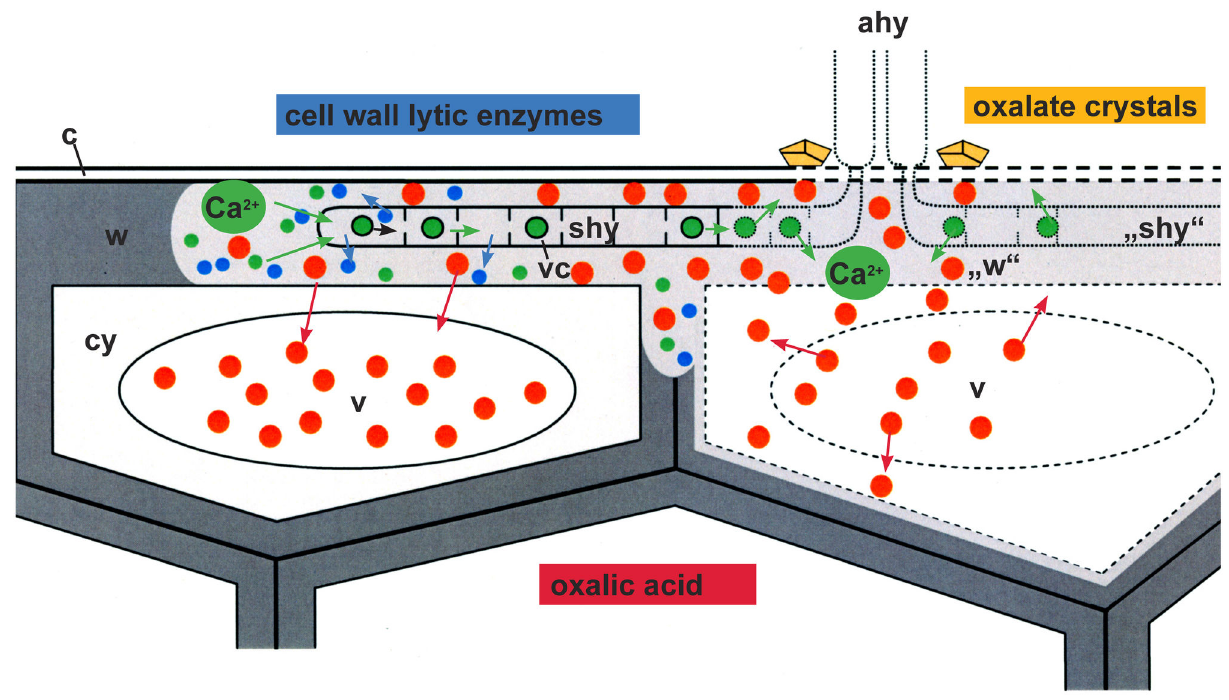
Figure 12. Infection model illustrating the complex interaction between S. sclerotiorum and its host cells sunflower. Scheme of two epidermal cells infected by hyphae of S. sclerotiorum . After penetration of the cuticle (c) by appressorial hyphae (ahy), subcuticular hyphae (shy) grow in the outer epidermal wall layer (w) and live on the cell wall matrix (intact wall in dark grey, degraded cell wall matrix in light grey (“w”). Subcuticular hyphae (shy) secrete cell wall lytic enzymes (blue dots) and oxalic acid (red dots) that do not kill the host cells immediately (intact cell compartments in continuous lines; degraded cell compartments in broken lines). While the enzymes degrade the matrix of the host cell walls and set free calcium (green dots), oxalic acid (red dots) is metabolized by the host cells and stored in the host cell vacuoles (v). Calcium is taken up by the growing hyphae in vesicles (vc) and translocated back to the older part (“shy”) to prevent un-physiological high calcium concentrations. Finally, host cells die (broken lines), because the degradation of cell walls advances and the concentration of oxalic acid rise. Oxalic acid (red dots) and also vacuolar enzymes of the host cells are set free and an autolytic degradation start from the inner side of the host cell walls contributing to the development of necrotic tissue. After death of the senescent hyphae (broken lines), calcium is again set free and is reacting with oxalic acid building stable calcium oxalate crystals (yellow) in the necrotic tissue around the functionless appressorial hyphae (ahy) of the infection